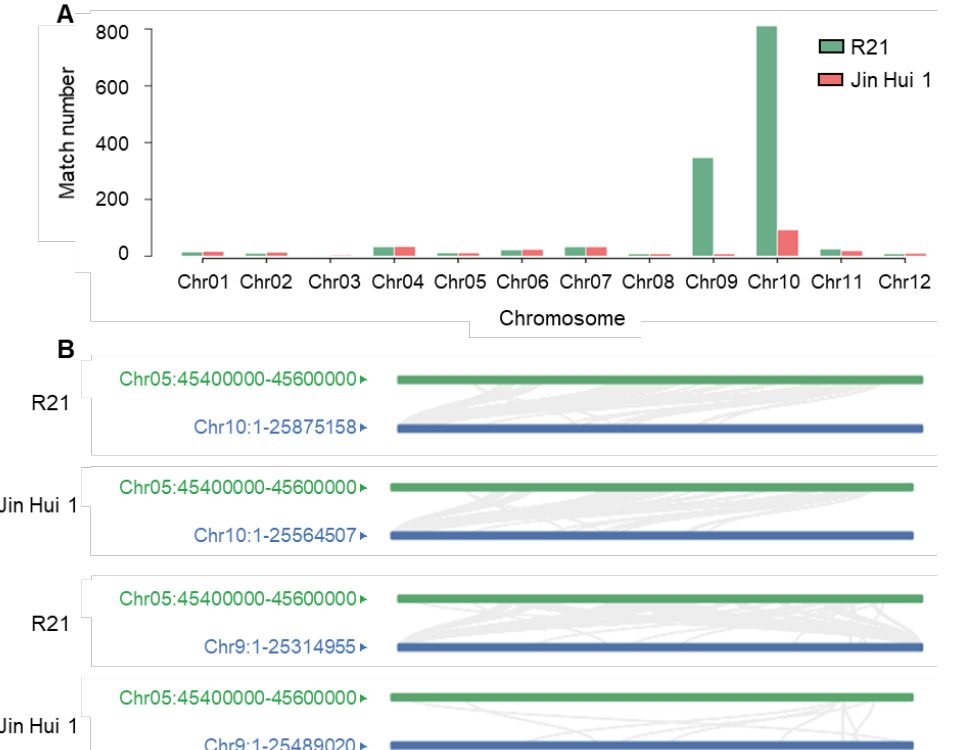
Figure 3. Collinearity analysis of sorghum insertions/homologous fragments with R21 and Jin Hui 1 genomes. ( A ) The alignment results of sorghum candidate analysis sequences blast against two rice genomes; ( B ) The collinearity results of sorghum candidate analysis sequences with chromo- somes 9 and 10 of R21 and Jin Hui 1 genomes. Green labels represent the 45.4 – 45.6 Mb interval of chromosome 5 in sorghum, blue labels represent the full length of chromosomes 9 and 10 in rice.